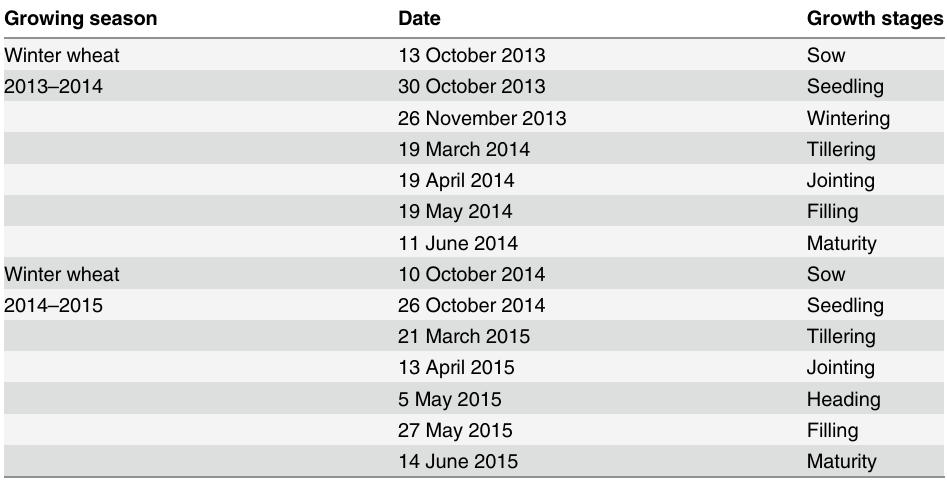
Table 1. Main growth stages of winter wheat during 2013 – 2014 and 2014 –